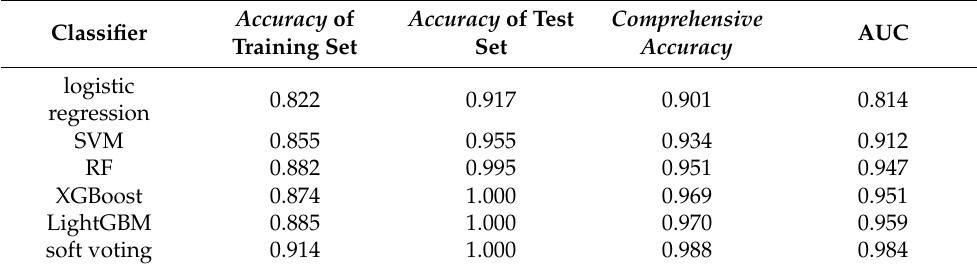
Table 2. Simulation